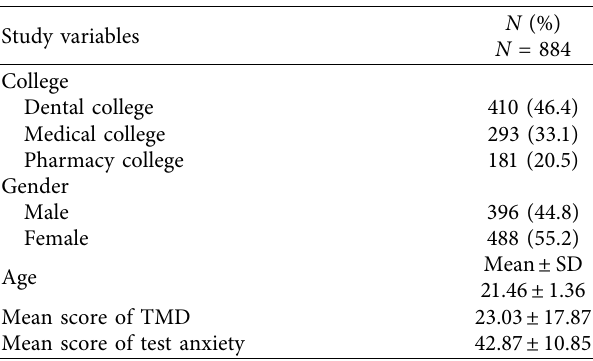
Table 1: Characteristics of study participants. Study